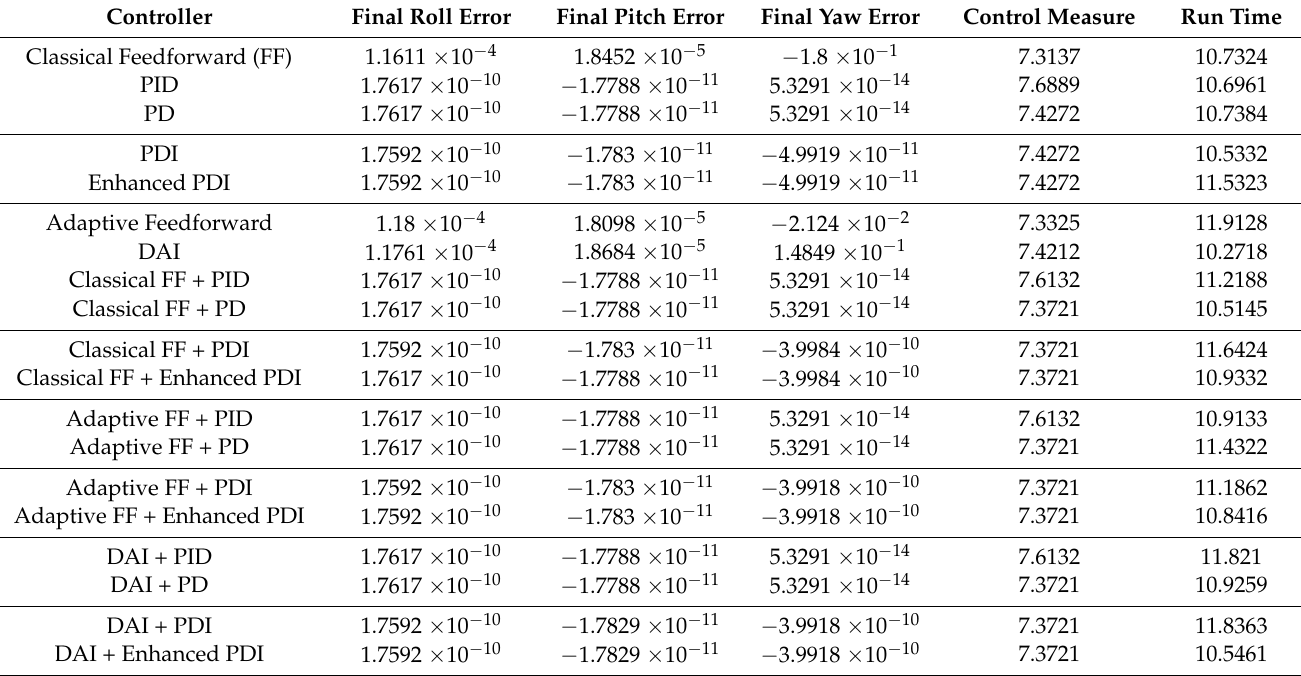
Table 2. System responses for various controller architectures in response to Pontryagin based trajectory for a symmetric